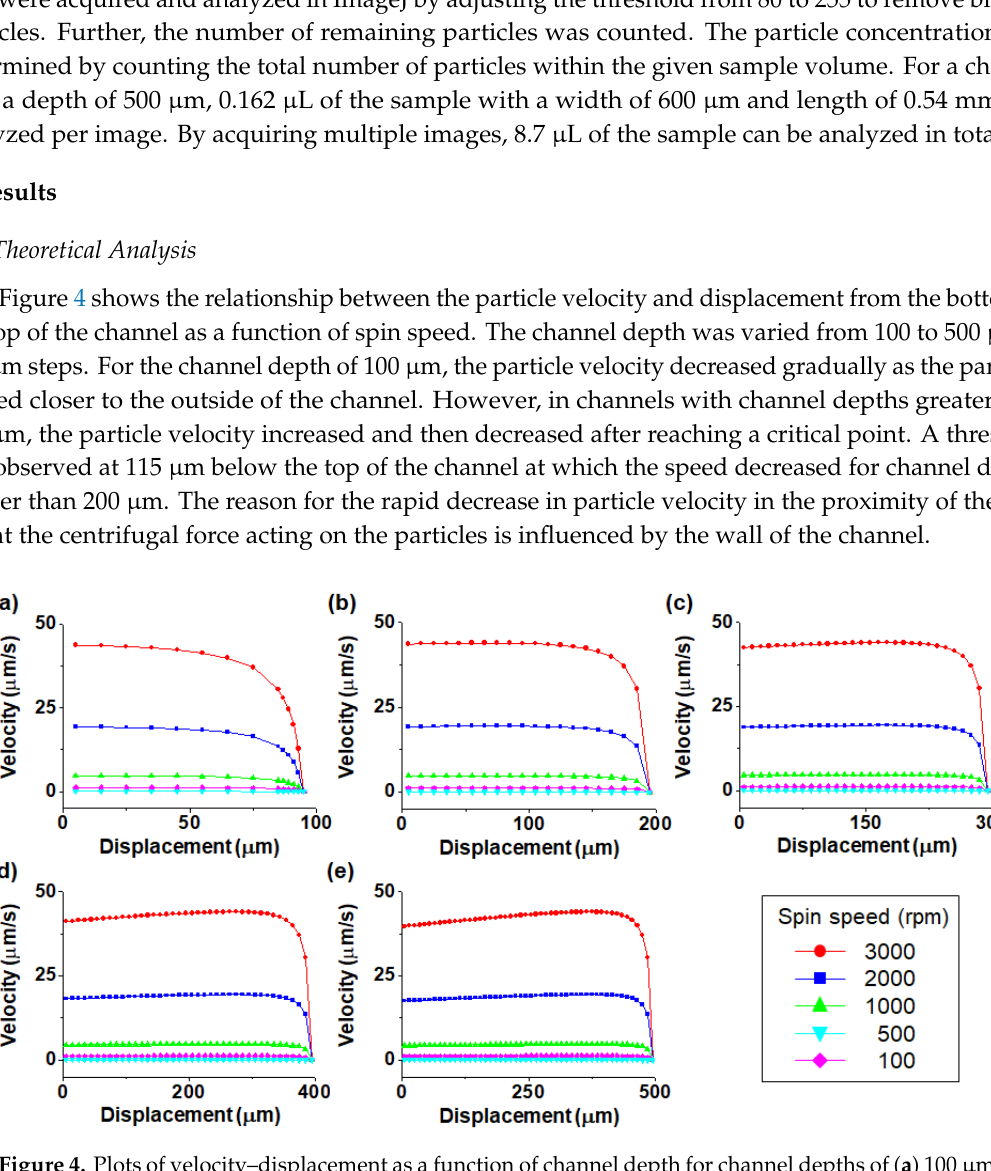
Figure 4. Plots of velocity–displacement as a function of channel depth for channel depths of ( a )